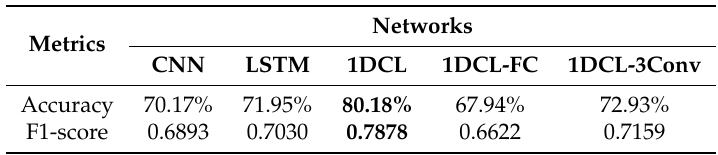
Table 2. Performance of Feature-Learning Approaches.